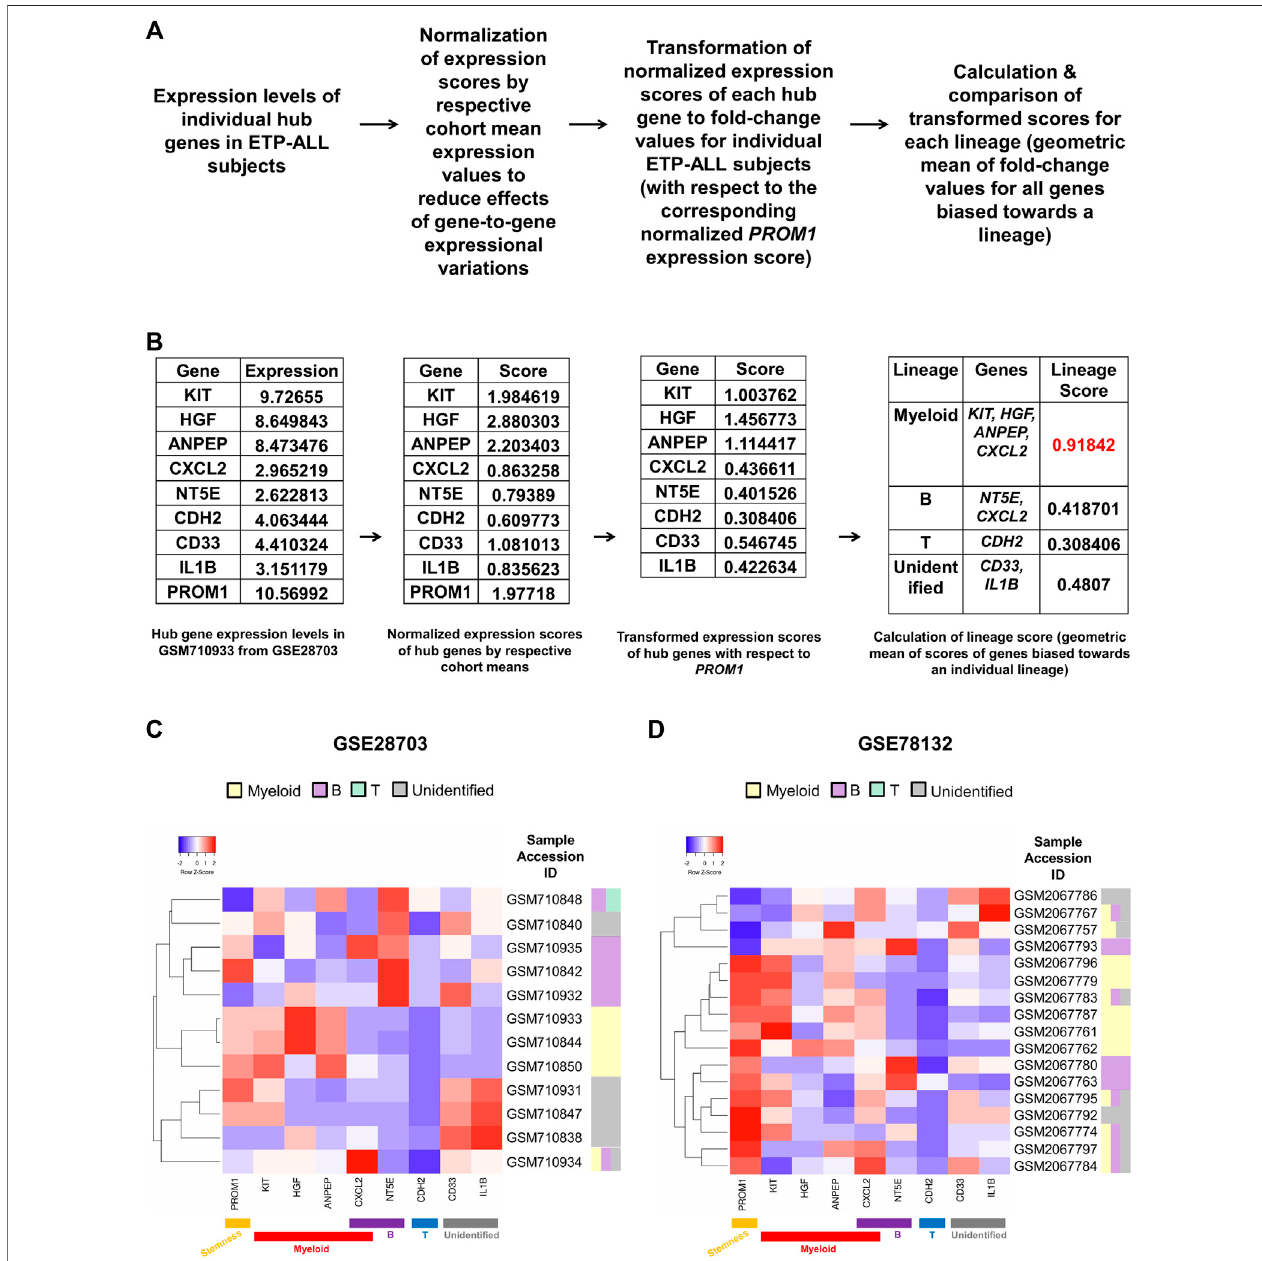
FIGURE 8 | Formulation of a personalized score signifying the net lineage bias of the ETP-ALL blasts. (A) Mathematical derivation of the lineage score from the expression values of hub genes from individual patient samples. (B) Calculation of lineage score for the GSM710933 sample from the GSE28703 dataset. The lineage withthehighestlineagescore(labeledinred)wasassignedtothesample. (C,D) PredictivelineageassignmentsforeachsamplefromGSE28703 (C) andGSE78132 (D) based on the lineage score calculation.